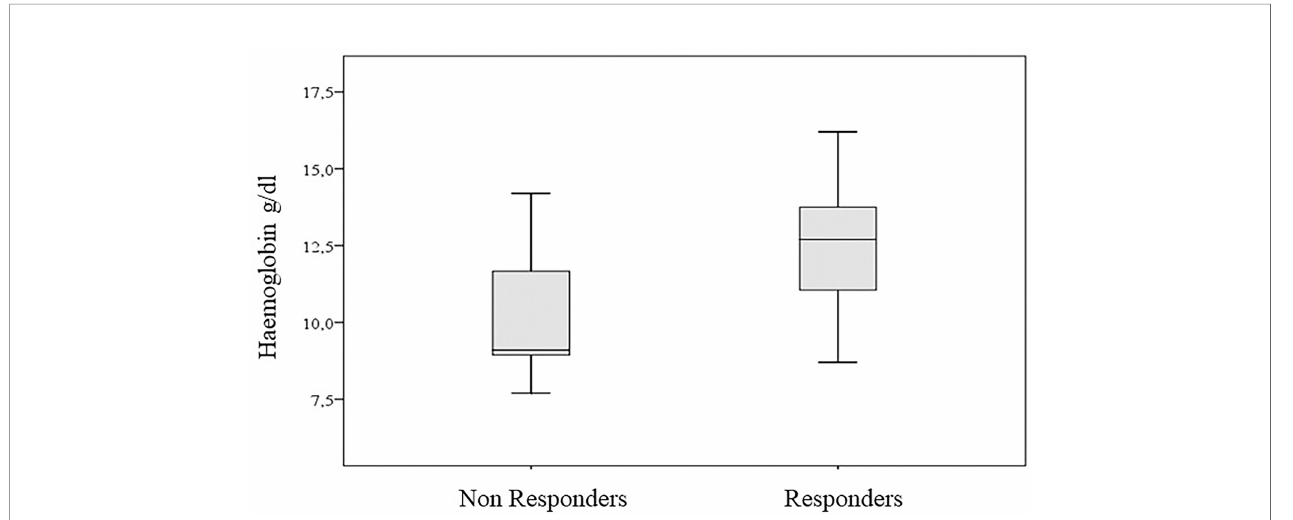
FIGURE 6 | Trends of the main blood parameters according to clinical response. Twenty-four patients were considered eligible (three patients were excluded for concomitant hematological tumors, one for thalassemia major, and two for concomitant immunosuppressive therapy). For non-responders, data from the 6-month sampling are not